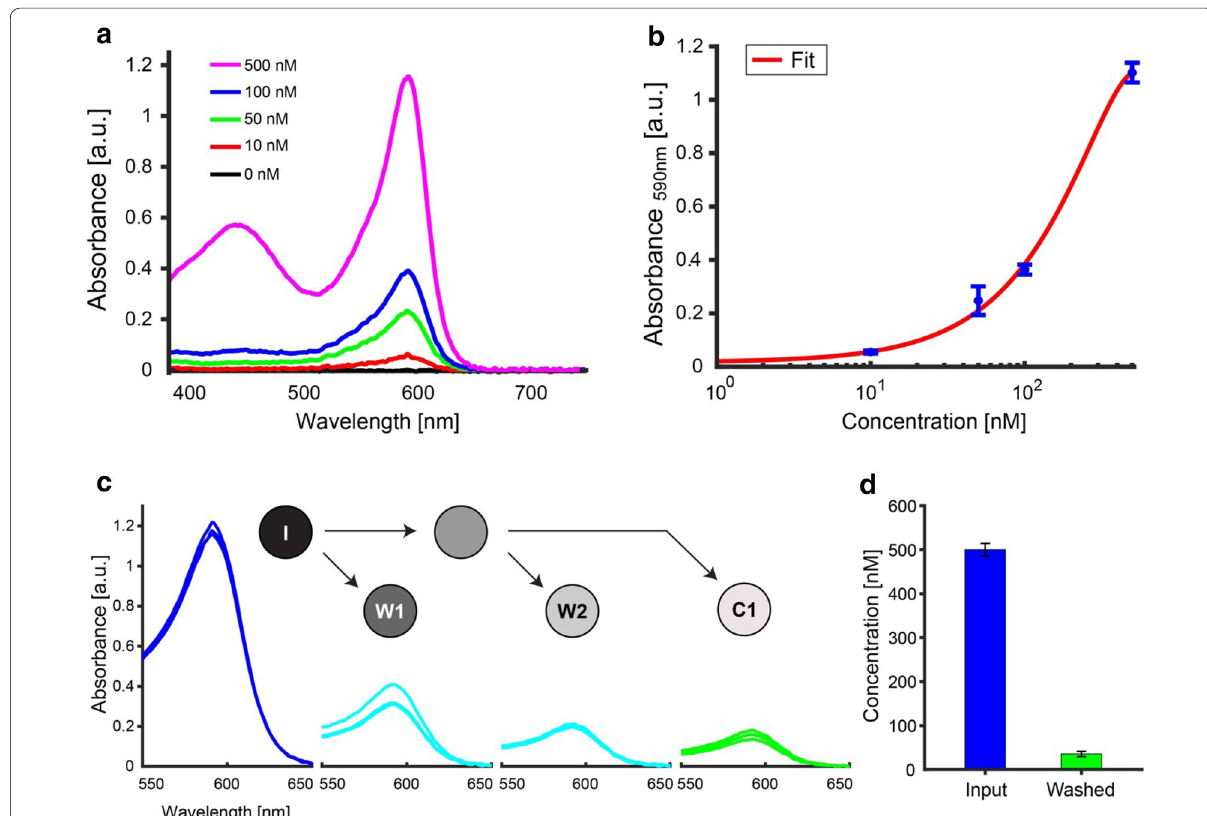
Fig. 6 Dye based measurements of droplet concentration. a Visible absorbance spectra from bromophenol blue dye. b From the absorbance spectra a calibration curve can be established to measure unknown concentrations between 500 nM and about 10 nM. c Bulk absorbance spectra in triplicate derived from washed droplets (I—input, W1—waste 1, W2—waste 2, C1—collection 1). d Wash concentration change as determined from 590 nm bromophenol blue absorbance and the calibration curve in